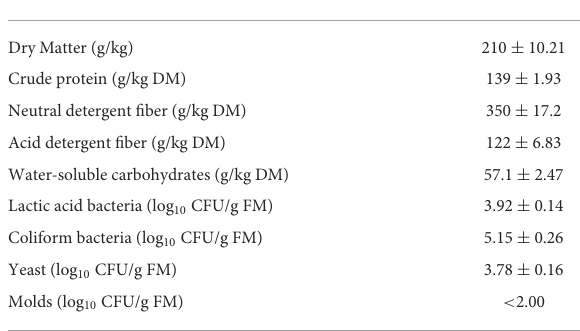
TABLE 1 Characteristics of the fresh Napier grass before ensiling ( ± SD, n =